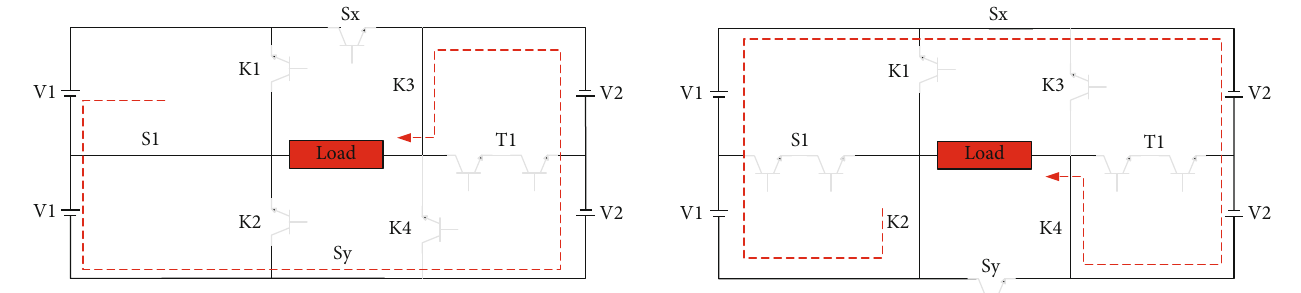
Figure 16: Current fl ow for the 14 th switching pattern.